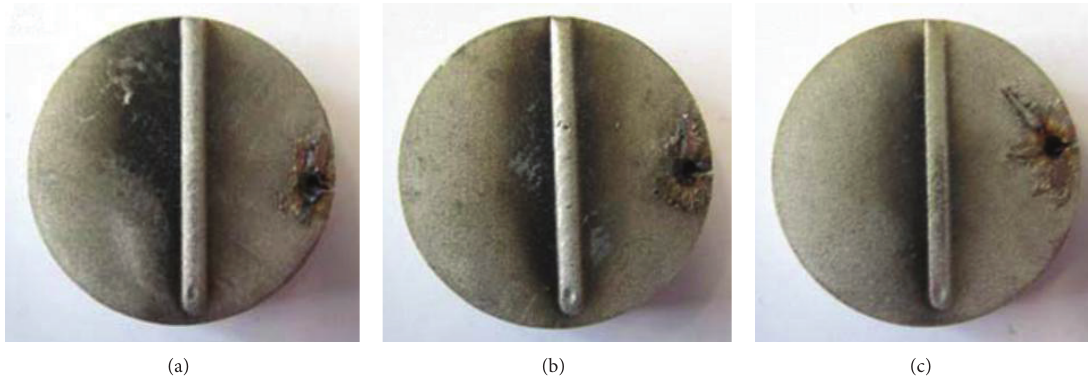
Figure 4: Samples made to detect the single-track clads widths 𝑊 𝑖 at different translation speeds.